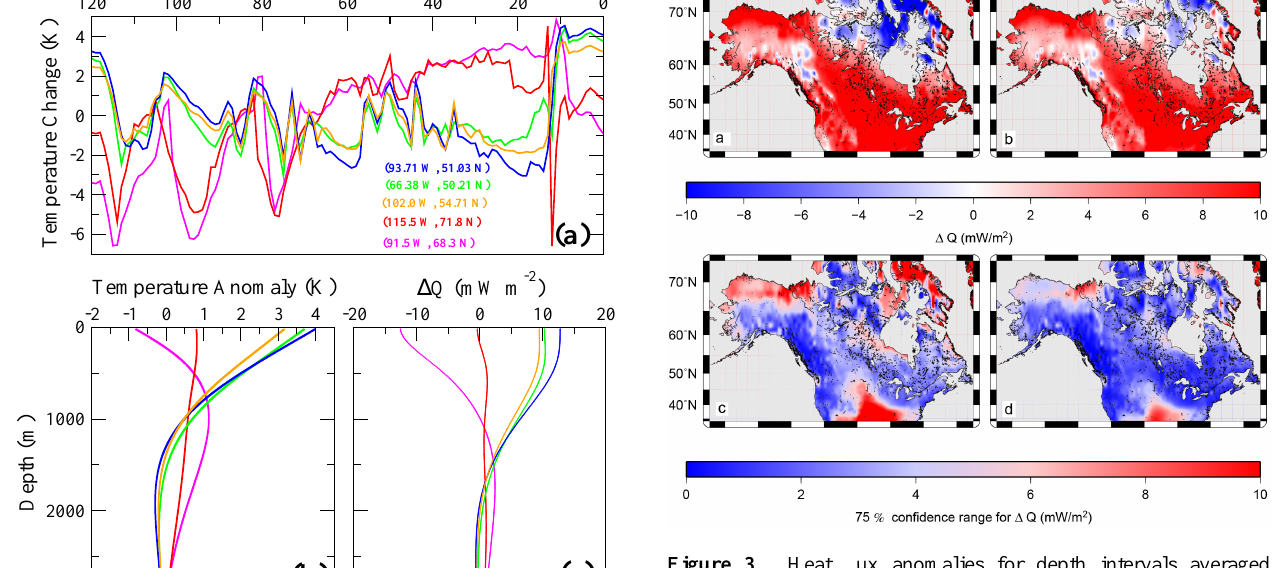
Figure 3. Heat flux anomalies for depth intervals averaged over depth intervals of (a) 100–200m and (b) 500–600m. Pan- els below represent the corresponding distribution of the abso- lute value of the 75% uncertainty of each of the above heat Figure 2. (a) Basal temperature evolution simulated by the MUN- Fig.2. (a)BasaltemperatureevolutionsimulatedbytheMUN-GCMforthelast120Ka. (b)Resultantpresent- day subsurface temperature perturbations associated with the basal temperature time series shown in panel a. flux perturbations. Additional results for the full depth interval GCM for the last 120ka. (b) Resultant present-day subsurface tem- (c)Resultantpresent-daysubsurfaceheatfluxperturbationsassociatedwiththebasaltimeseriesshowninpanel down to 2000m are given in the Supplement to this article at perature perturbations associated with the basal temperature time a. series shown in panel (a) . (c) Resultant present-day subsurface heat flux perturbations associated with the basal time series shown in surface temperature variation and its corresponding uncertainty envelope. 275 panel (a) . BasaltemperaturesaretakenfromfivesitesinalatitudinaltransectasrepresentedinFigure1that also approximate the locations of observational measurements in boreholes. The basal temperature time series from these sites are shown in Figure2a as departures from the respective site-specific means. Figure2b plots the modeled subsurface temperature anomalies associated with the selected basal temperatures as a function of depth. A thermal diffusivity of (cid:20) = 10 (cid:0) 6 m 2 s was assumed as 280 representative of common nonporous crustal rocks (e.g., Drury, 1986; Beardsmore and Cull, 2001; 10